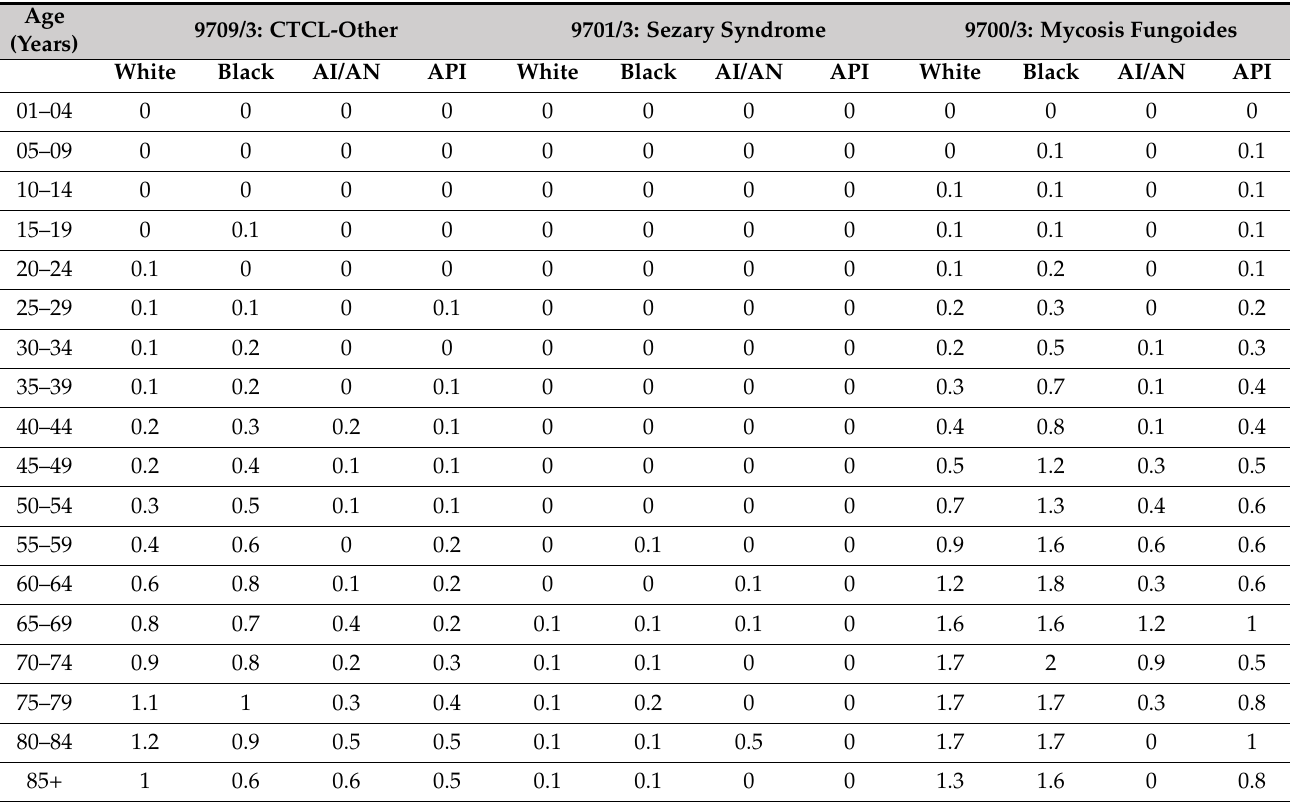
Table 5. National incidence by ICD-O-3 code diagnosis, sex, race, and age.